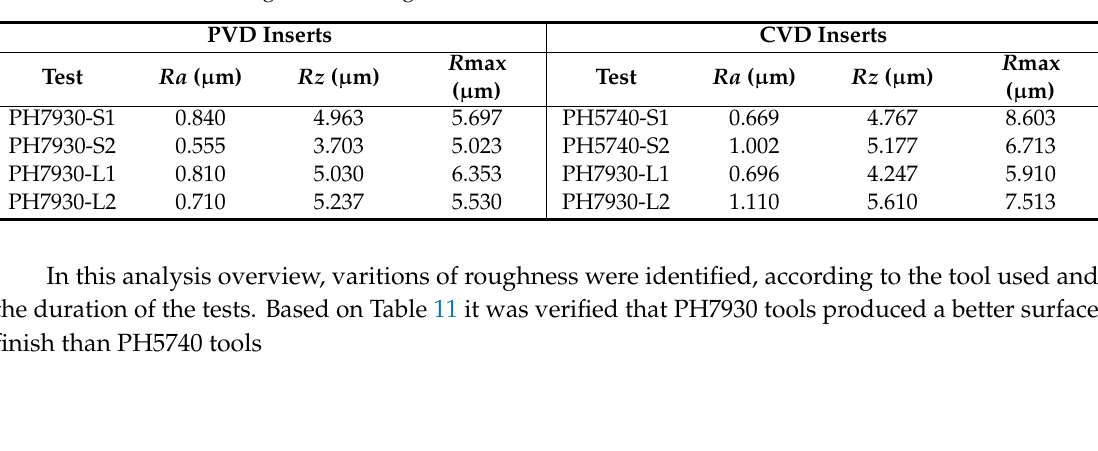
Table 11. Average surface roughness for all tests with both PVD and CVD coated